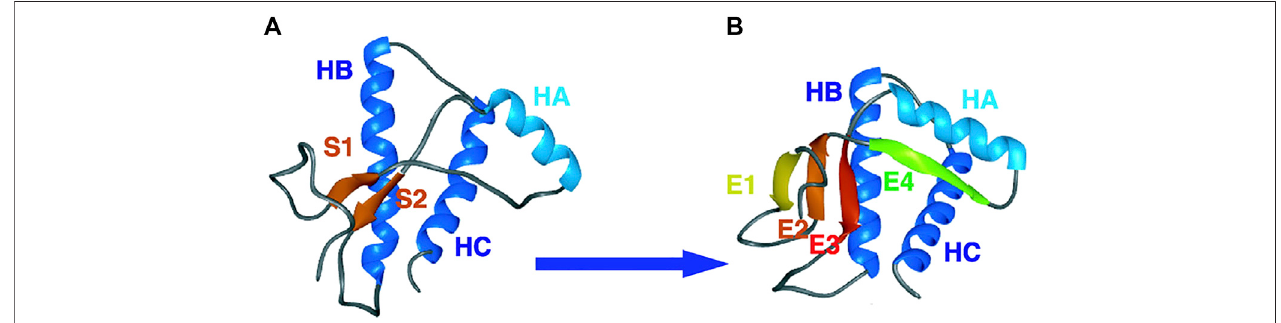
FIGURE2| Simulated conversion ofSyrian hamsterD147N PrP C toPrP Sc at lowpH levels. Thewild-type NMRstructureisshown (A) with thehelicesand strands labeled. A representative PrP Sc -like structure is shown (B) . Adapted from (DeMarco and Daggett, 2004), Copyright (2004) National Academy of Sciences,